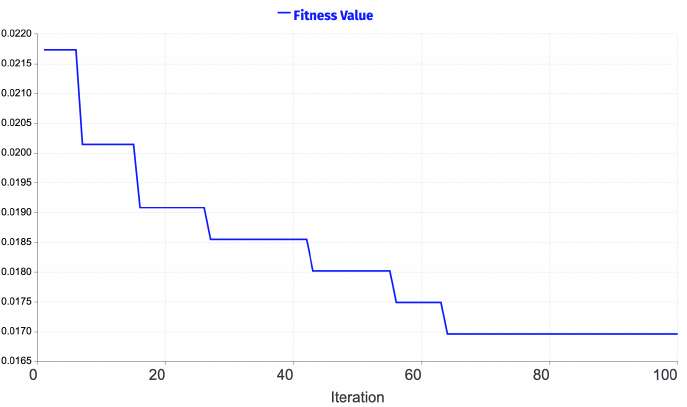
Figure A1. The training convergence curve when using the ANN with the PSO and the MSE fitness function for the dataset of Spanish companies.